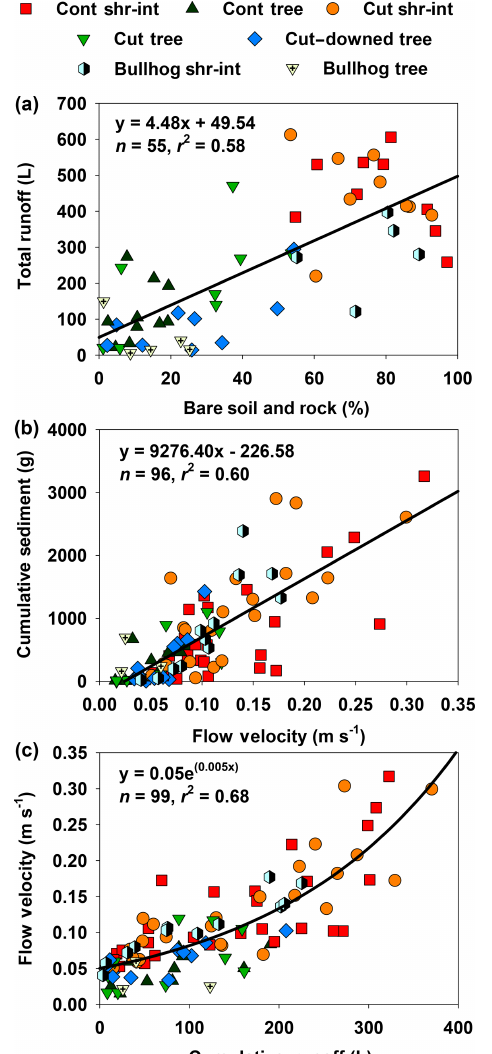
Figure 5. Example relationships/correlations in runoff and bare ground (bare soil plus rock cover) (a) , cumulative sediment and overland-flow velocity (b) , and overland-flow velocity and runoff (c) derived from a subset of the overland-flow dataset for the Mark- ing Corral and Onaqui sites, as presented in Williams et al. (2019a). Data from overland-flow simulations on untreated/control (cont) plots, cut treatment (cut) plots without and with a cut, downed tree (cut–downed tree), and bullhog plots (bullhog, Onaqui site only) in tree (tree) and intercanopy (shrub–interspace, shr-int) microsites 9 years after respective tree-removal treatments. The data demon- strate that, for the studied conditions, runoff is largely regulated by bare ground, sediment delivery is controlled by flow velocity, and flow velocity is strongly correlated with the amount or